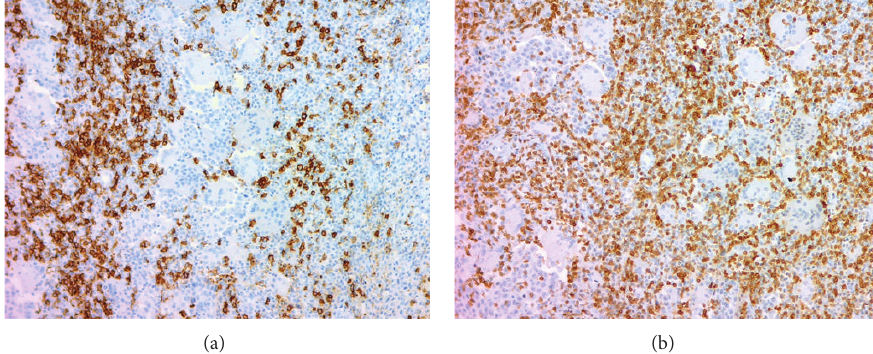
Figure 5: Reactivity to CD20 (a) and CD3 (b) showed a reactive pattern of the lymphocytic infiltrate. Immunohistochemical stain with anti-CD20 (a) and anti-CD3 (b) antibodies, ×